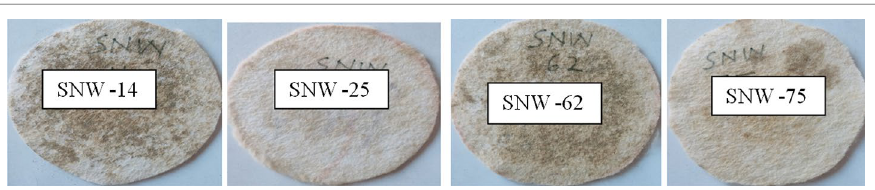
Fig. 2 Superior needle-punched nonwoven